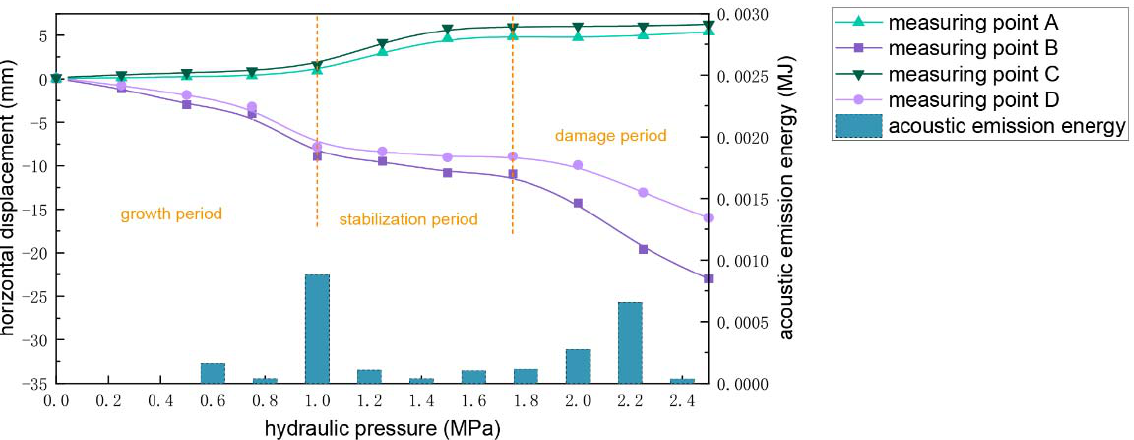
Figure 24. The relationship between the acoustic emission energy and the convergence deformation of the measurement point with the water pressure of the karst cave for model 2.